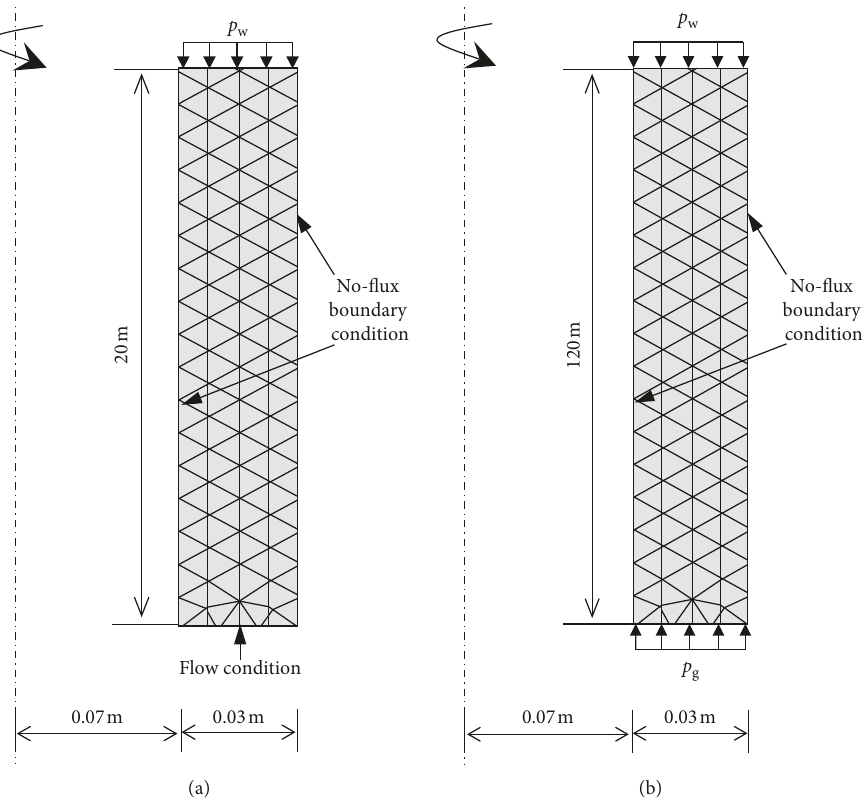
Figure 8: Finite element axial-symmetric mesh and boundary conditions for concentric annulus grouting. (a) Cement and sodium silicate grout injected under flow control condition. (b) Cement slurry injected under pressure control condition.